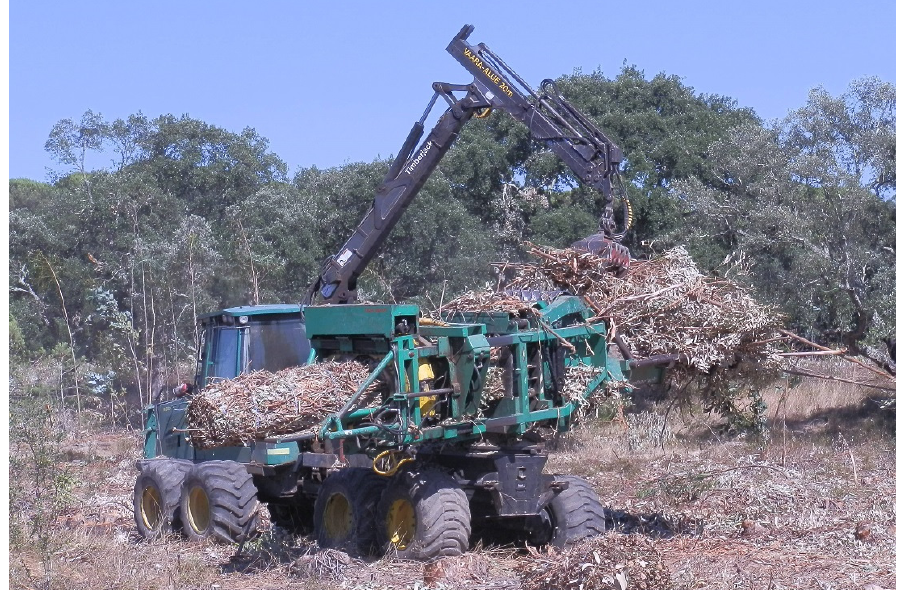
Figure 1. The John Deere 1490 bundling unit observed in this study.